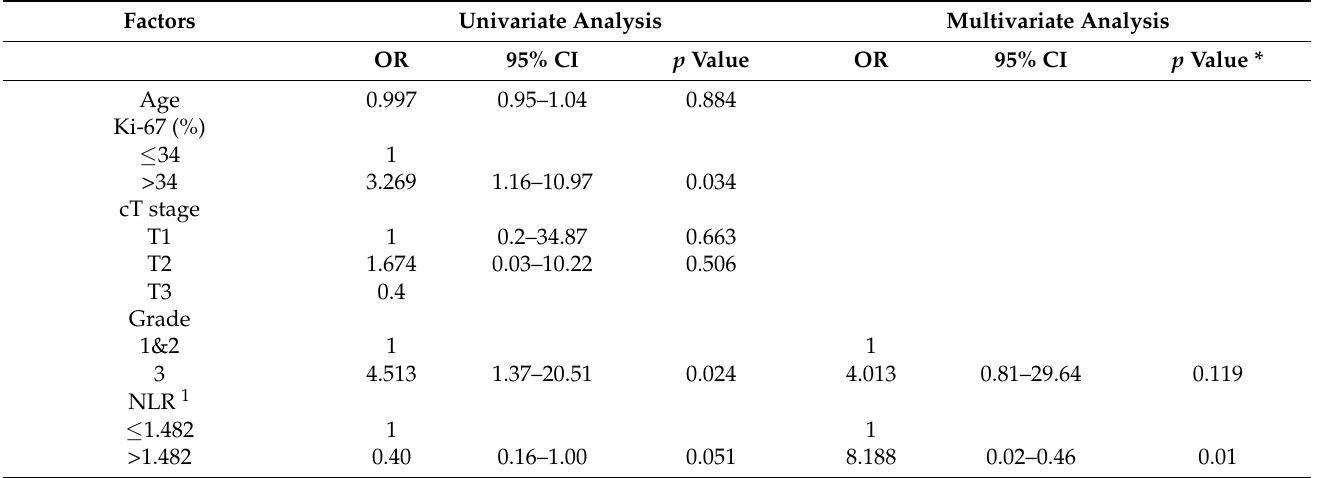
Table 2. Factor predicting pCR for NAC patients analyzed by using univariate and multivariate